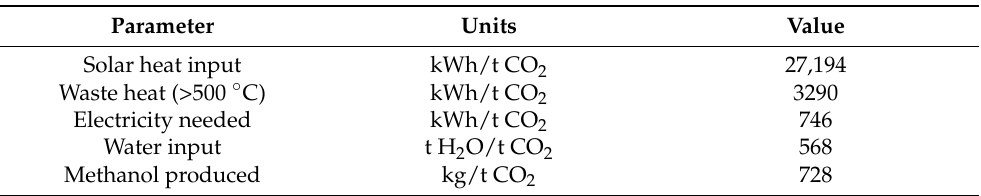
Table 3. Summary of the results for the synthetic fuel production model, which are valid for all